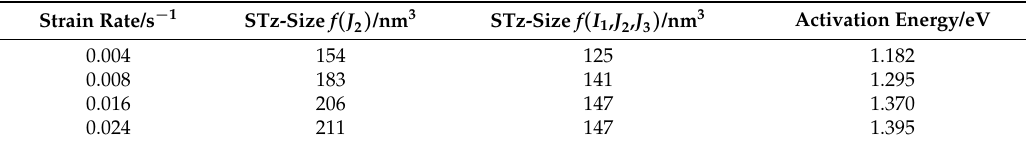
Table 2. Parameters of indentation size effects under different strain